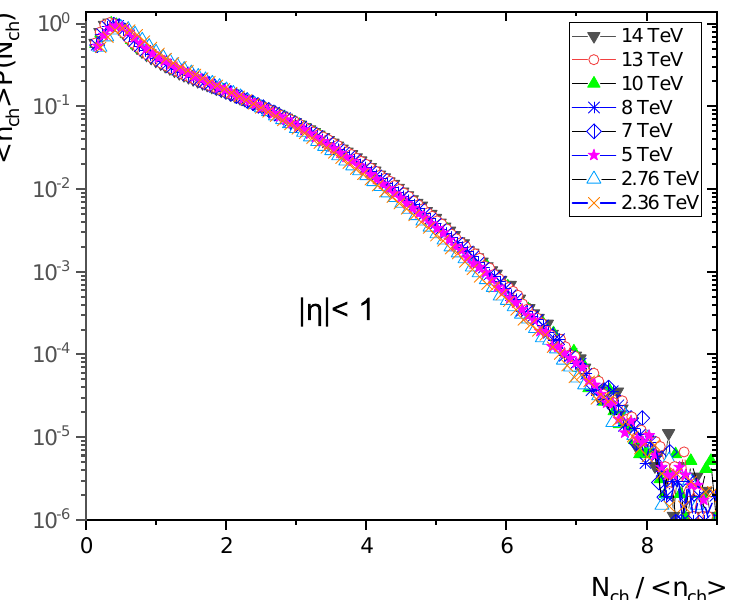
Figure 8. KNO form of charged particle multiplicity distribution at different energies in pseudorapid- ity | η | <